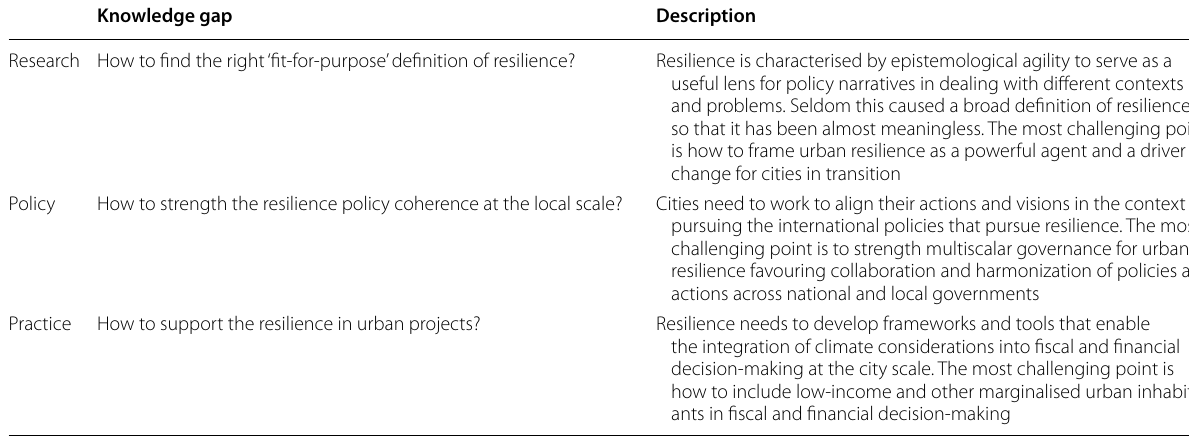
Source: Authors’ elaboration based on Prieur-Richard et al.